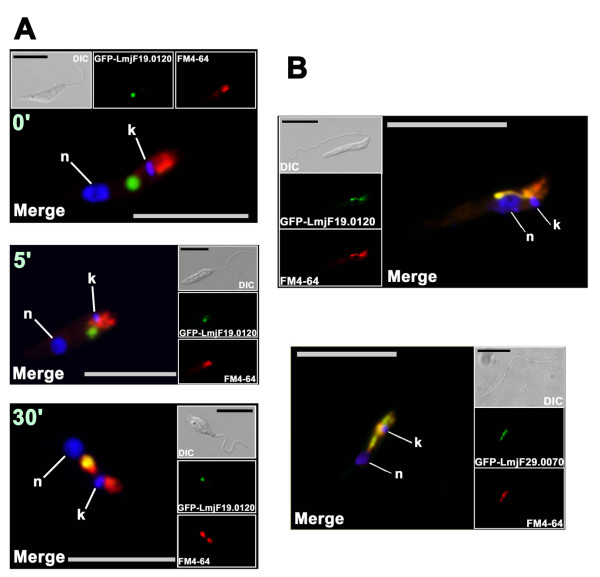
GFP-LmjF19.0120 and GFP-LmjF29.0070 localise to the endo-lysosomal pathway in L. major. (A) Co-localisation of GFP-fused LmjF19.0120 with fluorescent endo-lysosomal tracer FM4-64 after incubation for increasing amounts of time (top) with live L. major promastigotes. (B) Localisation of GFP-LmjF19.0120 (top) and GFP-LmjF29.0070 (bottom) in a tubular compartment in live L. major stationary-phase promastigotes. Differential interference contrast (DIC) image, GFP fluorescence image (green) and the signal given by FM4-64 (red) after 30 minutes of incubation are presented in the insets and the two fluorescent signals are shown merged together with the DAPI staining of DNA (blue; n: nucleus; k: kinetoplast, mitochondrial DNA) in the enlarged images. Co-localised signal is shown in yellow. Scale bar = 10 μm.